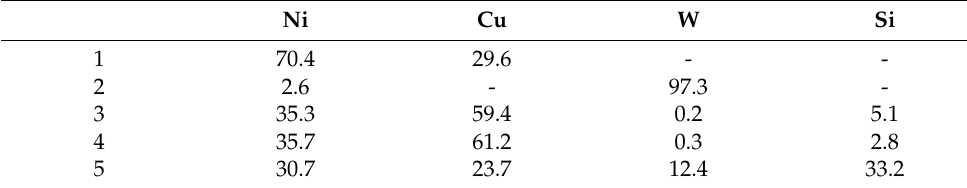
Figure 4. Cross-sectional morphology of the Ni–Cu coating and Ni–Cu–10(W,Si): ( a ) cross-sectional morphology of the Ni–Cu coating; ( b ) bonding interface between the Ni–Cu coating and the substrate; ( c ) cross-sectional morphology of the Ni–Cu–10(W,Si) coating; ( d ) bonding interface between the Ni–Cu–10(W,Si) coating and the substrate; ( e ) structure of the middle area of the Ni–Cu–10(W,Si) coating; ( f ) morphology of the upper part of the Ni–Cu–10(W,Si) coating. Based on the XRD diffraction pattern and elemental content shown in Table 2, white- dotted points are WSi 2 (point 5). Cellular crystals were mainly composed of Ni–Cu and Ni x Si y (point 4) because Si atoms in the crystal were embedded in the Ni–Cu lattice and formed a stable phase of NiSi 2 . Due to grain boundaries with high energy and chemical instability, sub-stable phases (such as Ni 31 Si 12 and Ni 2 Si) are segregated at the grain bound- aries, resulting in the enrichment of Si (point 3). Table 2. EDS elemental (at.%) composition of the coatings shown in Figure 4.